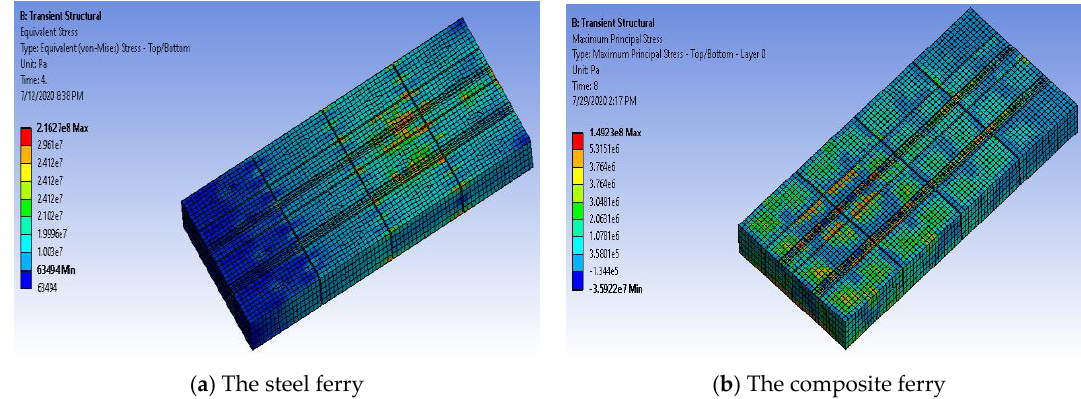
Figure 25. Stress distribution over ferries for case 2.